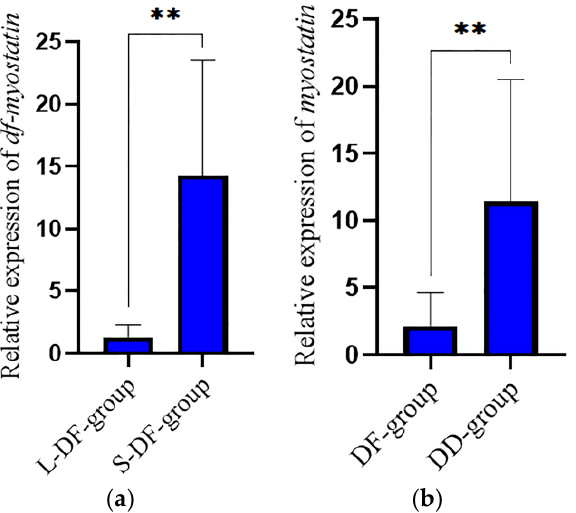
Figure 6. Expression pattern of myostatin mRNA. ( a ) Expression of hdh-myostatin in adductor muscle between fast-growing (L-DF-group) and slow-growing (S-DF-group) groups. ( b ) Expression of myostatin in adductor muscle between H. discus hannai (DD) and lvpan abalone (DF). ** indicate significant differences ( p < 0.01).